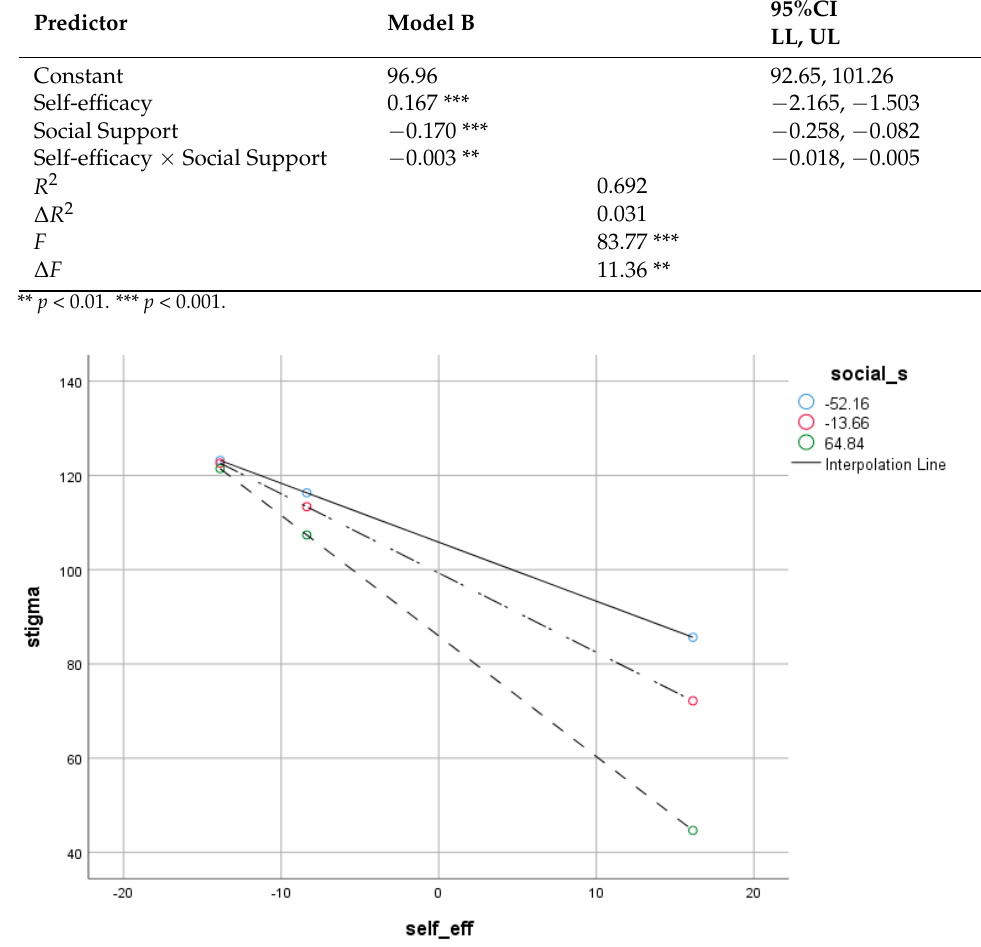
Figure 1. Mod Graph Showing the Interaction Effect of Social Support and Self-Efficacy.